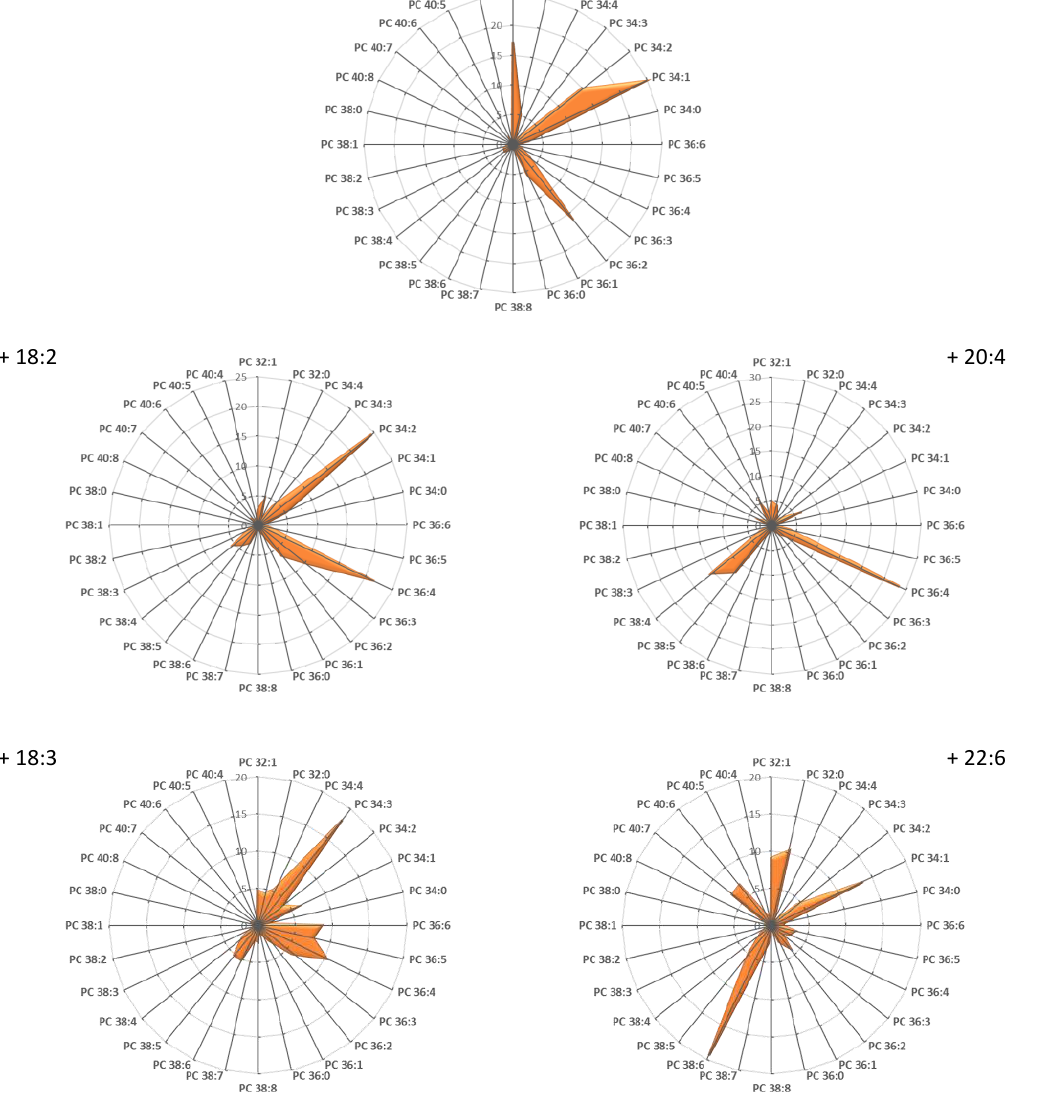
Figure 4. C2C12 incorporate differently exogenous fatty acids within their phospholipids. C2C12 myoblasts were cultivated for 16 h in the presence of 100 µ M of the indicated fatty acids. PC subspecies distribution in each case is displayed. The total carbon chain length (x) and number of carbon–carbon double bonds (y) in the acyl chains of the main PC molecular species (x:y) are indicated. Values are means of four independent determinations in each case. 3.3. PUFA Induce the Formation of Membrane Invaginations under Mechanical Constraints To evaluate if cell membranes may respond differently to changes in area and shape depending on the fatty acyl composition of their PLs, we labeled C2C12 myoblasts with the FM1-43 probe, which becomes intensely fluorescent at 515 nm once inserted in the outer leaflet of the plasma membrane [16,17]. We observed membrane dynamics by mod- ifying cell volume in response to exposure to a medium with a 55% reduction in osmolar- ity (osmotic downshock). Under similar conditions, fibroblasts or neurons have been shown to form dome-shaped micrometer-sized invaginations termed vacuole-like dila- tions (VLDs), which have been hypothesized to constitute a mechanism to accommodate excess membrane area upon osmotic-induced cell shrinking [34,35]. It has been hypothe- sized that, during osmotic downshock, the flowing bilayer of nascent VLDs may be water